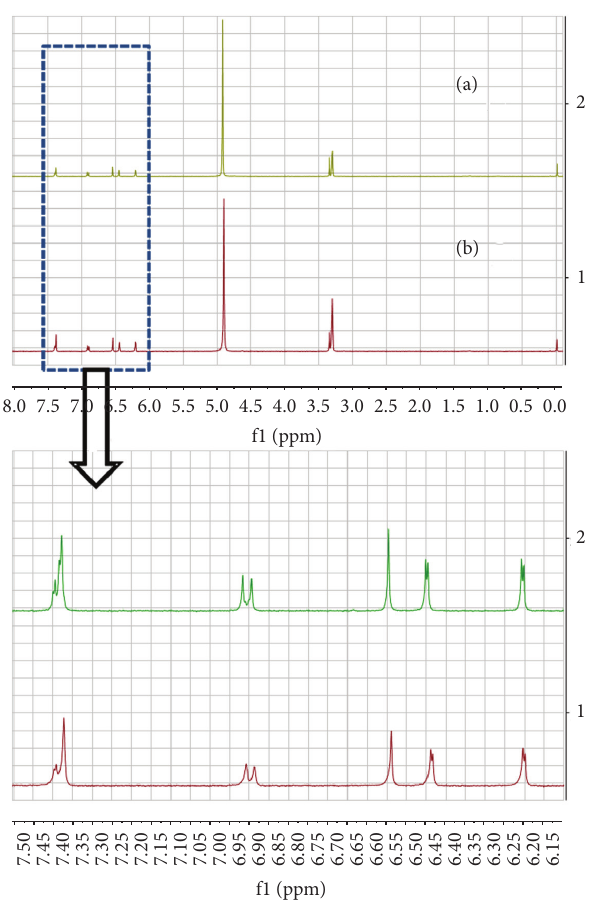
Figure 1: Luteolin was allowed to react with anhydrous calcium chloride, anhydrous zinc chloride, magnesium chloride hexahy- drate, iron chloride hexahydrate, or copper chloride dihydrate. After removal of free ion salts, the reactants were analyzed by 1 H- NMR spectroscopy. (a) Free luteolin was used as a control; (b) ethyl acetate solute.